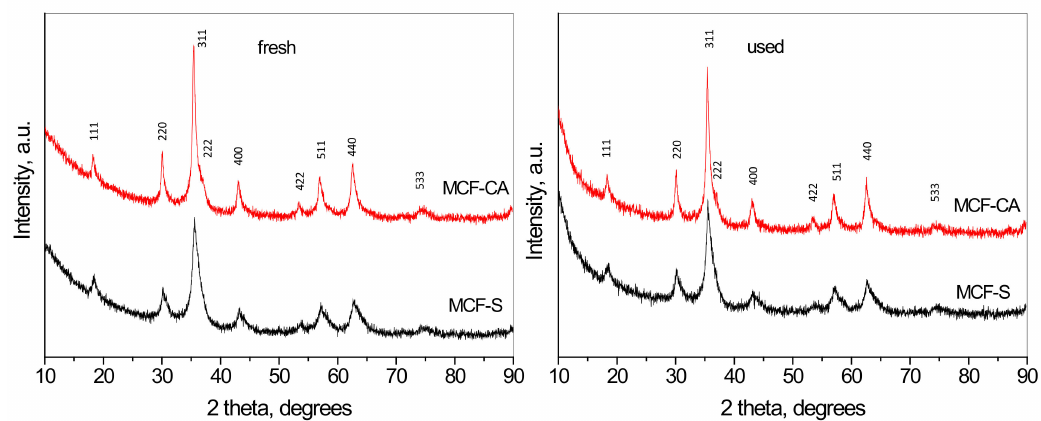
Figure 1. XRD patterns of the fresh and used spinel samples.